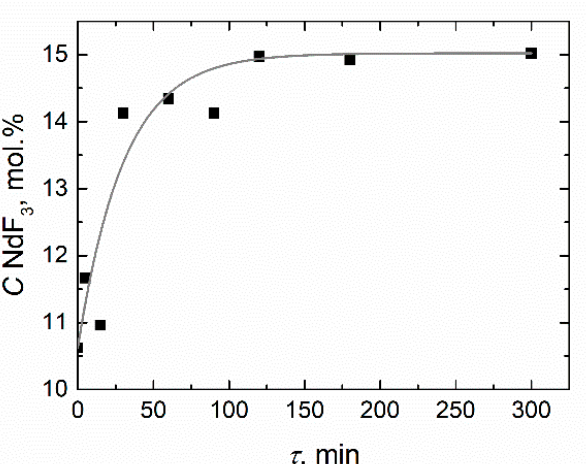
Figure 4. The dissolution dynamics of the NdF 3 (5 mol.%) addition in the molten FLiNaK–NdF 3 (10 mol.%) at 700 ◦ C.